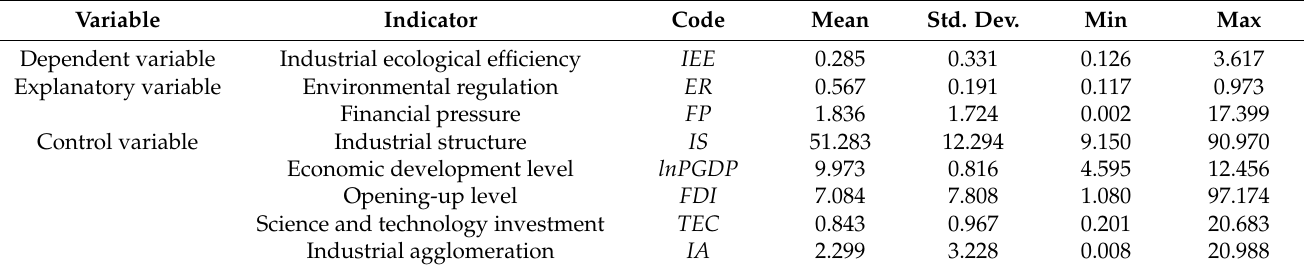
Table 2. Descriptive statistics of